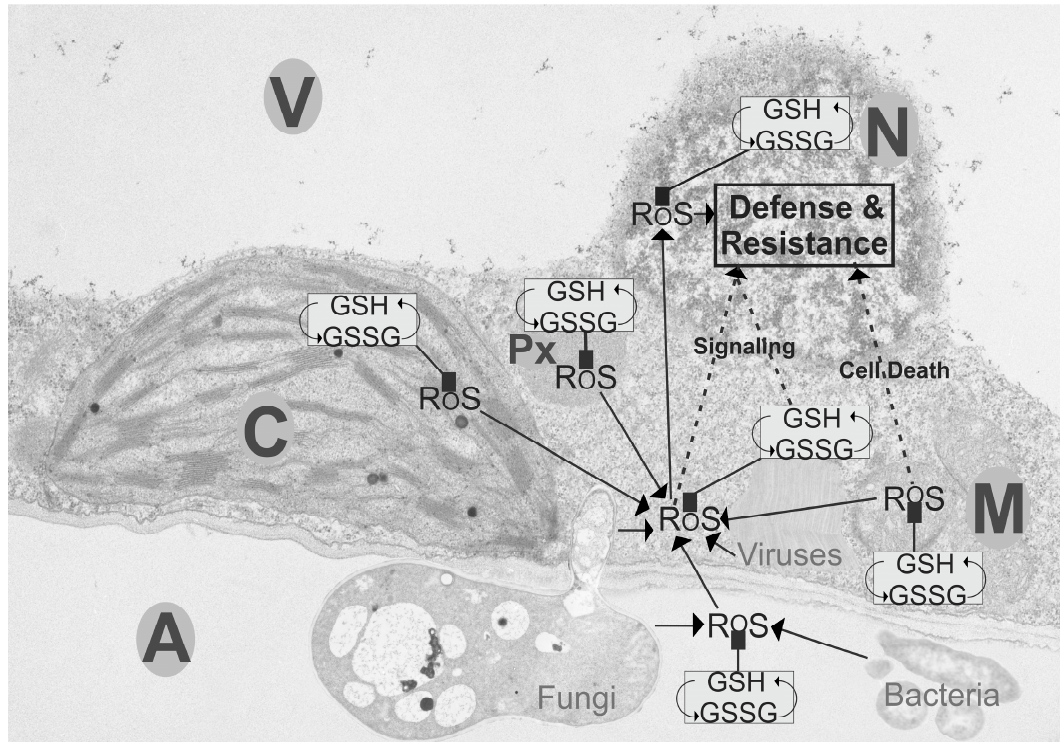
Figure 3. Compartment-specific roles of glutathione and reactive oxygen species (ROS) during plant defense. Transmission electron micrograph of a leaf cell with overlay demonstrating the roles of glutathione (GSH, GSSG) and ROS in the activation of plant defense during biotic stress. The first line of defense in plants is the apoplast, where during biotrophic fungal infection, the accumulation of ROS and GSSG activates plant defense and leads to resistance. During pathogen attack, the depletion of glutathione in mitochondria and a change towards GSSG leads to the accumulation of ROS, which causes mitochondrial dysfunction, activates cell death, and triggers resistance. The accumulation of glutathione in chloroplasts and peroxisomes at the early stages of plant pathogen interactions is related to increased tolerance and the development of resistance. The collapse of the antioxidative system in both compartments at the later stages of infections enforces cell death through retrograde signaling. During biotic stress situations ROS and GSSG generated in the di ff erent organelles di ff use, or get transported, respectively, into the cytosol where they can change the redox state of glutathione and modify proteins. Proteins are then sent to the nucleus, where they activate the expression of defense gene through pathways that involve SA, JA, auxins, and abscisic acid. While ROS can also di ff use into nuclei and directly activate the expression of defense genes, such e ff ects have not been demonstrated for glutathione yet. Within nuclei glutathione mediates gene expression through detoxifying ROS and acting as a redox bu ff er for antioxidant enzymes, which can then lead to modifications of transcription factors and activation of defense gene expression. A, apoplast, C, chloroplasts, M, mitochondria, N, nuclei, Px, peroxisomes, V,